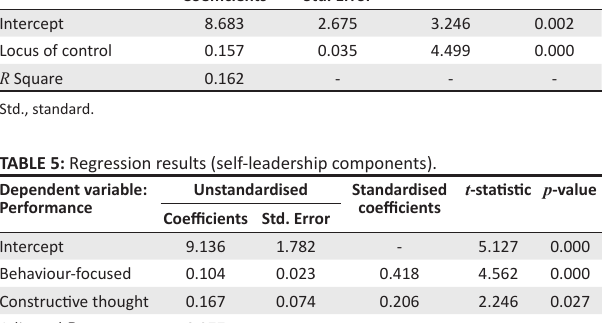
TABLE 4: Regression results (locus of control only). Dependent variable: